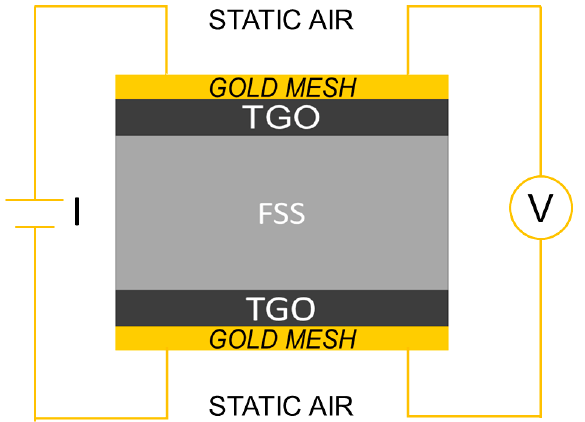
Figure 1. Schematic drawing of Area Specific Resistance (ASR) measurement setup.